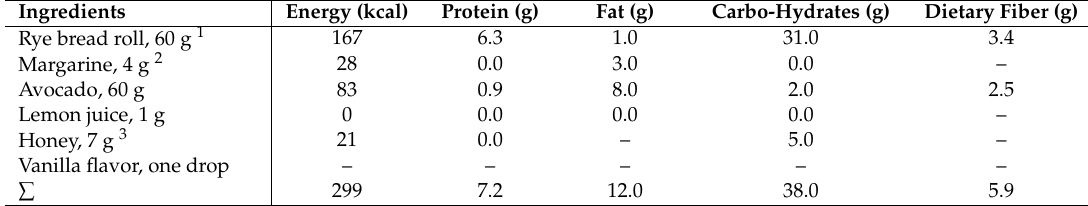
Table 1. Energy and nutrient content of the breakfast suitable for